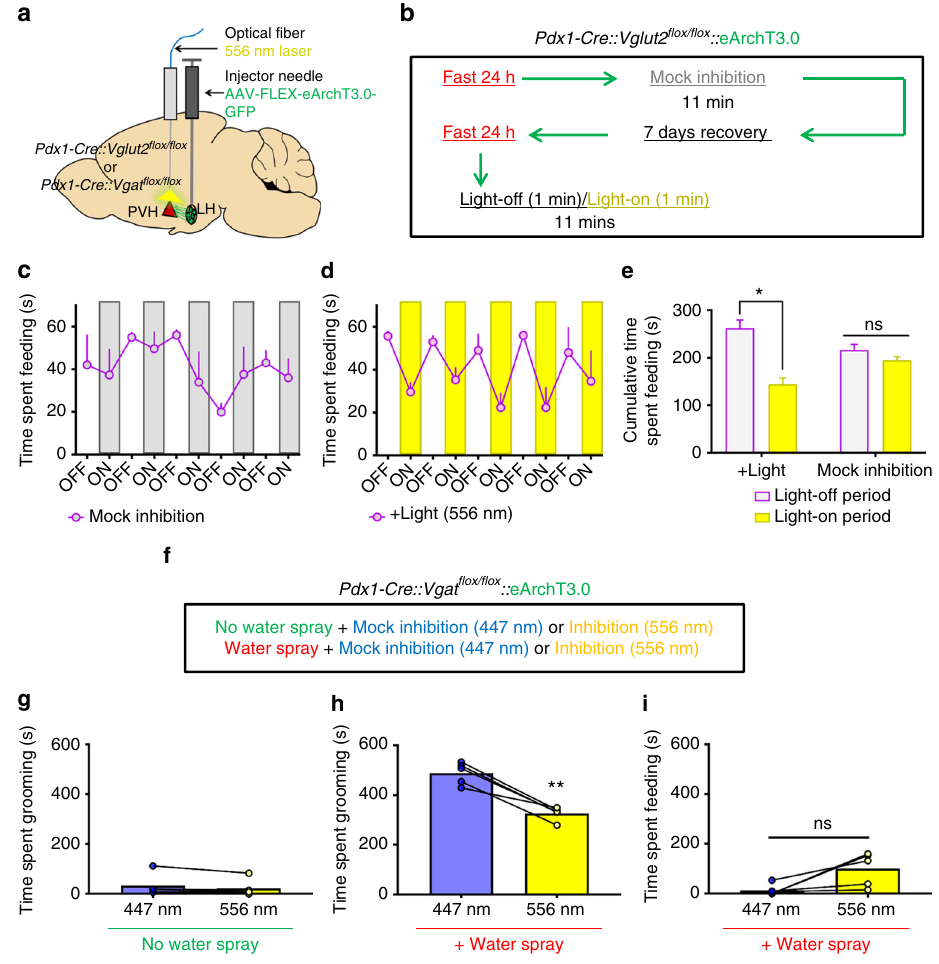
Fig. 5 Inhibition of GABAergic LH Pdx1 → PVH fi bers reduces feeding after a fast, and inhibition of glutamatergic fi bers reduces water-spray induced grooming. a Experimental schematic. b Experimental protocol used to test fast-refeeding in Pdx1-Cre::Vglut2 fl ox/ fl ox ::eArchT3.0 mice under mock or 556 nm light inhibition. c Time spent refeeding after a fast during mock inhibition trial. d Time spent re-feeding after a fast under + Light trial, whereby 556 nm constant light was applied every other minute during 10 consecutive minutes. e Comparison of cumulative time spent feeding during light-off vs. light-on periods during + Light and Mock inhibition trials. n = 3 animals. Two-way repeated measures ANOVA followed by Sidak ’ s multiple comparisons test; light group F (1, 2) = 0.01648, P = 0.9096; light period F (1, 2) = 45.77, P = 0.0212; interaction light group X light period F (1, 2) = 35.58, P = 0.0270. Light-off vs. Light-on period (+Light group) * p < 0.05. Data are presented as mean ± s.e.m. f Experimental protocol used to test water spray induced grooming in Pdx1-Cre::Vgat fl ox/ fl ox ::eArchT3.0 mice under mock (447 nm) or 556 nm light inhibition. g Time spent grooming during mock and 556 nm inhibition when no water spray was delivered. h Time spent grooming during mock and 556 nm inhibition when water spray was delivered to induce grooming. i Simultaneous time spent feeding during water spray trials. g – i Two-tailed paired Student's t test; n = 5; g t = 1.935, df = 4, p = 0.1250; h t = 7.779, df = 4, ** p = 0.0015; i t = 2.731, df = 4, p = 0.0524 (ns, not signi fi demonstrate that PVH neurons mediate light-evoked self- rons of Pdx1-Cre mice following photostimulation of LH Pdx1- ChR2-eArchT3.0 fi bers that simultaneously expressed eArchT3.0 and ChR2 (see Methods). Whereas blue light (473 nm) reliably evoked